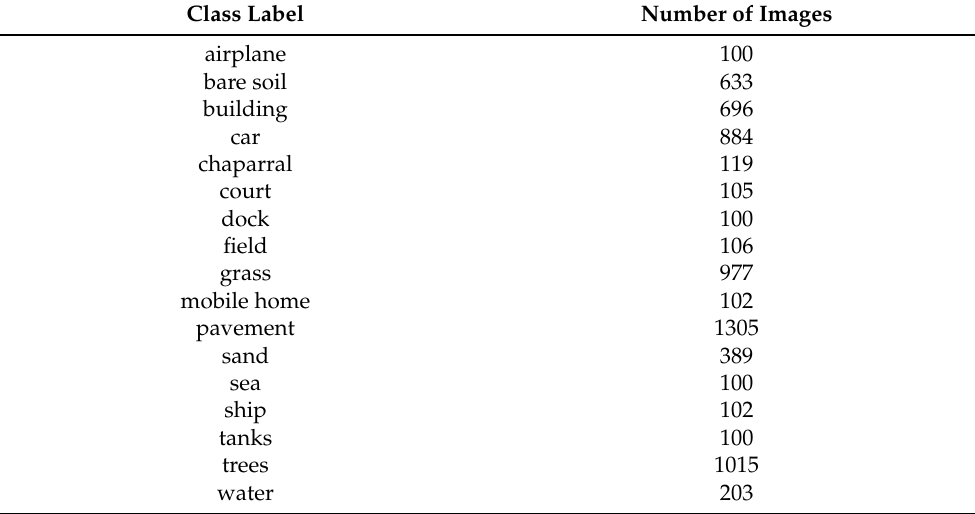
Table A1. Number of images associated with each class label in UC-Merced